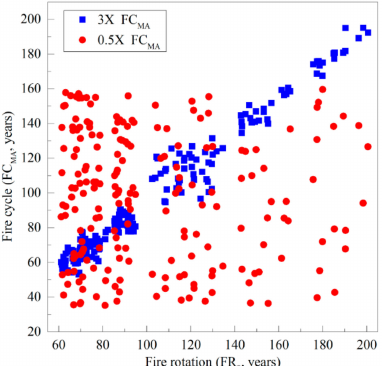
Figure 8. Relations between simulated fire rotation (FR S ) for the whole 2100 × 2100 grid simulated landscape and FC MA estimates for each of the 201 TSLF maps. Of the nine scales at which these analyses were conducted, two are depicted here: 3 × and 0.5 × . Each point represents one of the 201 TSLF maps. The R 2 adj and root mean square error (RMSE) are, respectively, 0.97 and 7.7 for the 3 × study area scale, and 0.03 and 54.4 for the 0.5 × study area scale; these values provide four of the points used in Figure